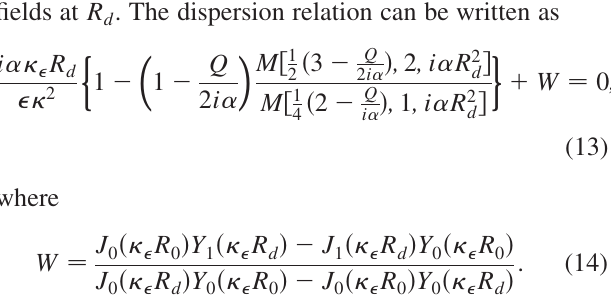
ð R Þ ¼ 0 0 z(cid:3)